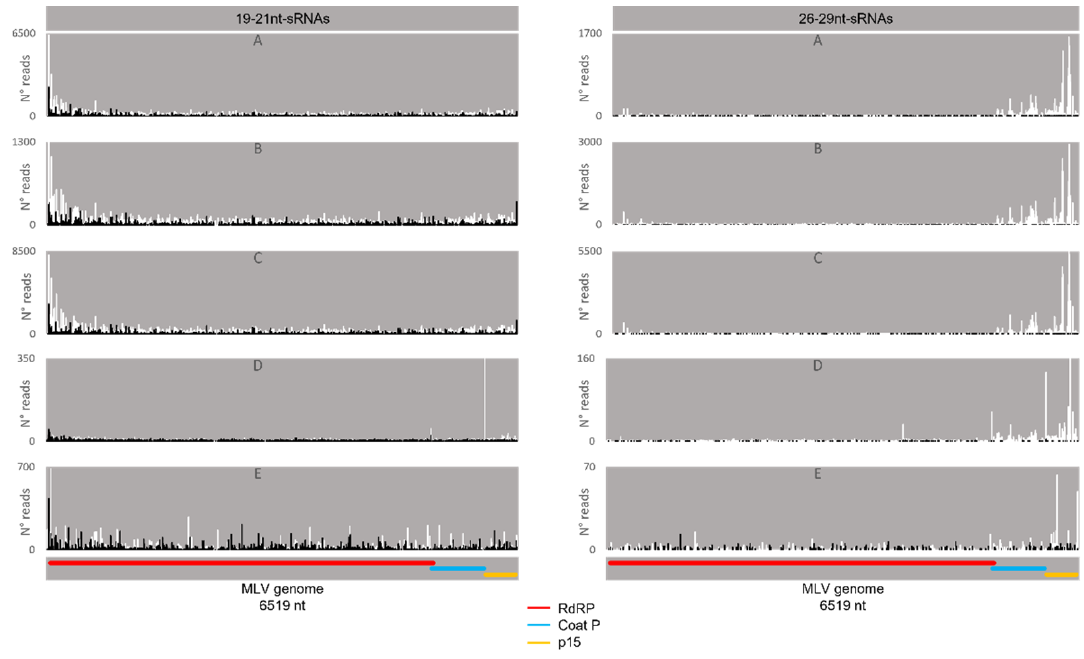
Figure 7. Distribution of BmN4 sRNAs mapping to B. mori Macula-like Latent Virus (MLV). Left: distribution of 19–21 nt-long sRNAs. Right: distribution of 26–29 nt-long sRNAs. White bars: sense reads. Black bars: anti-sense reads. A–E: represented databases, listed in Table S2. Red: RdRp ORF; blue: coat P ORF; orange: p15 ORF.